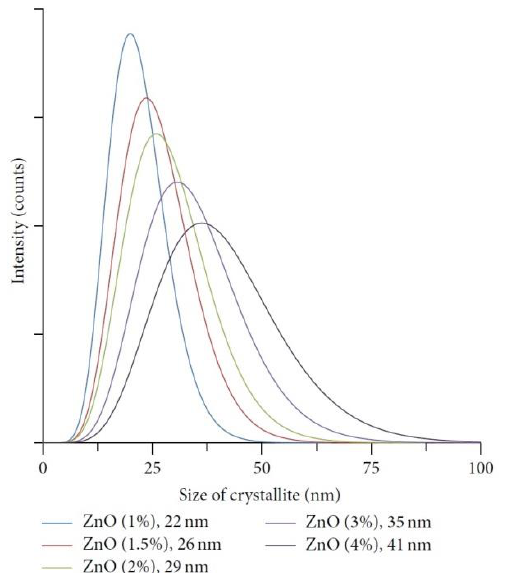
Figure 48. Crystallite size distribution of ZnO NPs obtained in the microwave solvothermal synthesis from precursor solutions with different H 2 O content. Reprinted with permission from [758],